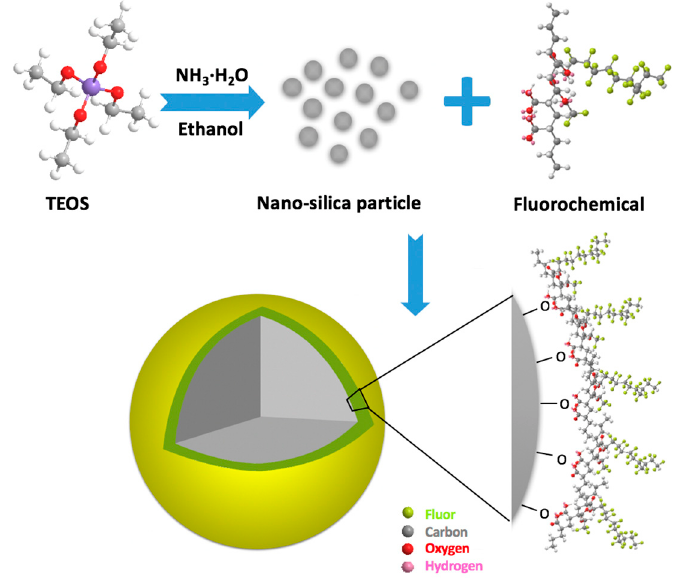
Figure 5. Sketch of the fabrication of nanoparticles with gas-wetting.